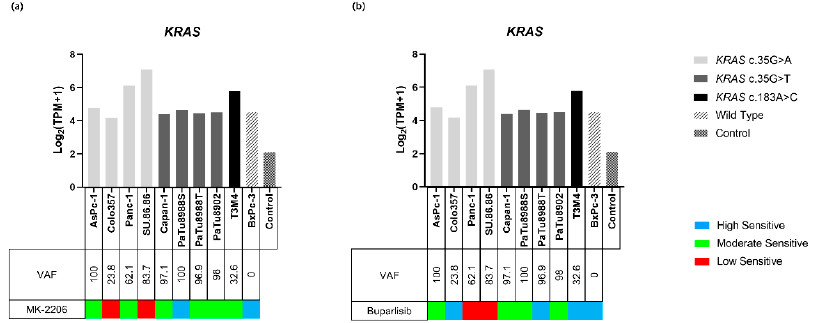
Figure 5. Gene expression of KRAS in ten PDAC cell lines and the control. The sensitivity to MK-2206 ( a ), Buparlisib ( b ), and the variants of KRAS are indicated for each cell line. Gene expressions are displayed as Log 2 (TPM + 1). Compared with the control group, expression levels of KRAS were increased in all cell lines.